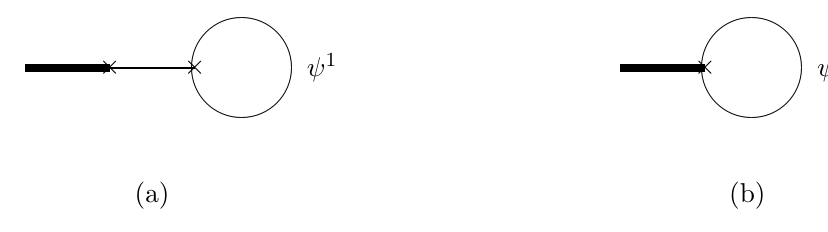
Figure 9 . Diagrams involving ψ 1 propagator that contribute to the annulus one point function of the closed string